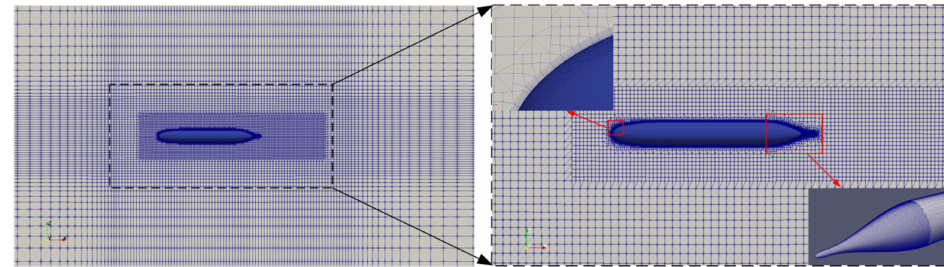
Figure 2. Computational